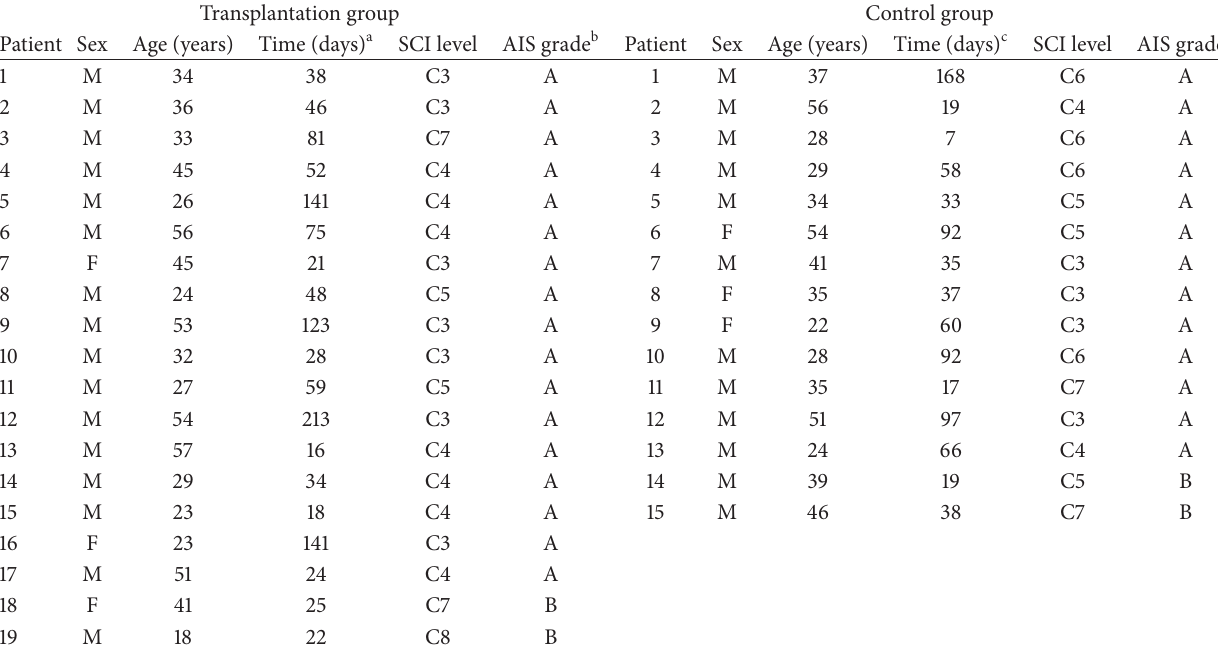
Table 1: Demographic, clinical, and neurological features of the patients. Transplantation